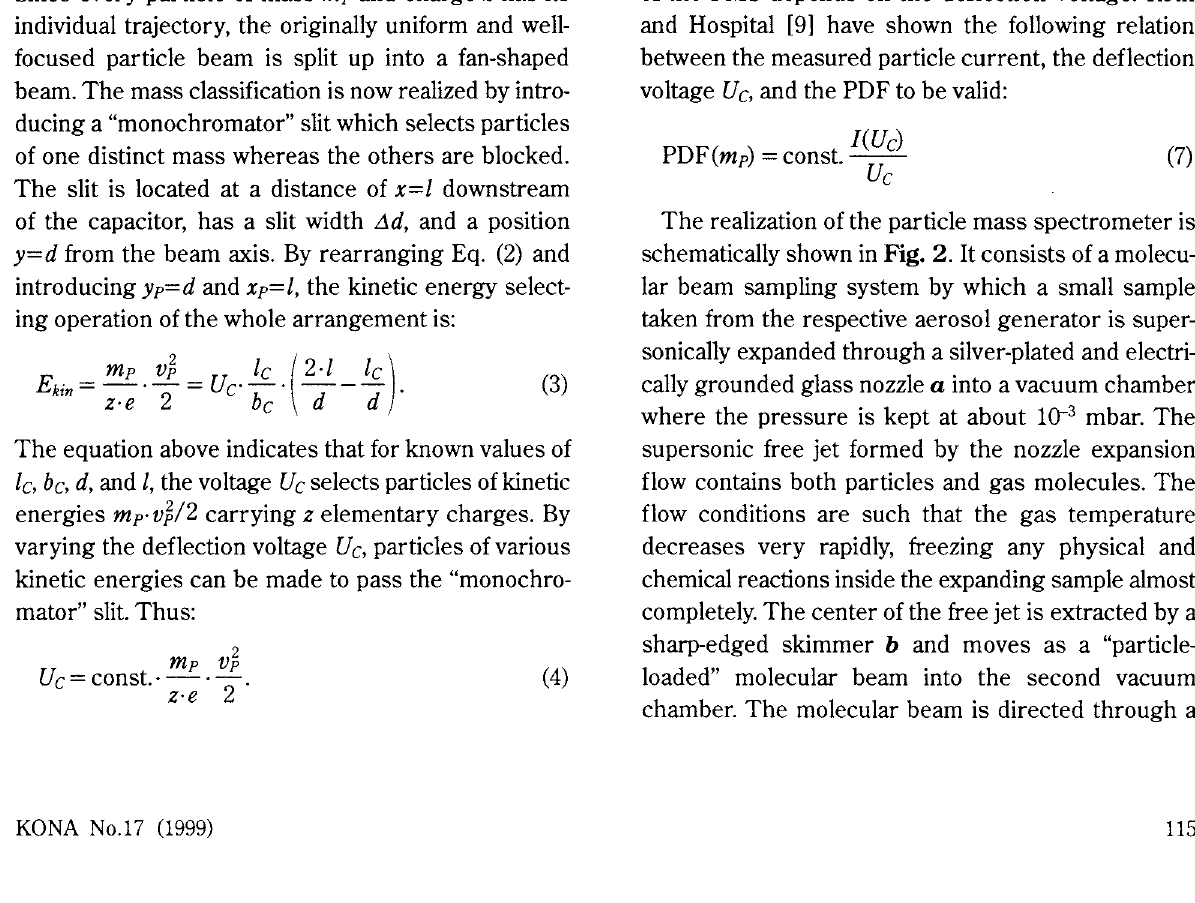
Left-hand side: deflection of charged particles in an elec tric field and resultant particle trajectories in a vacuum containment. Right-hand side: formation of particle pack ages and operation of the electrical filter supplied with synchronously pulsed high